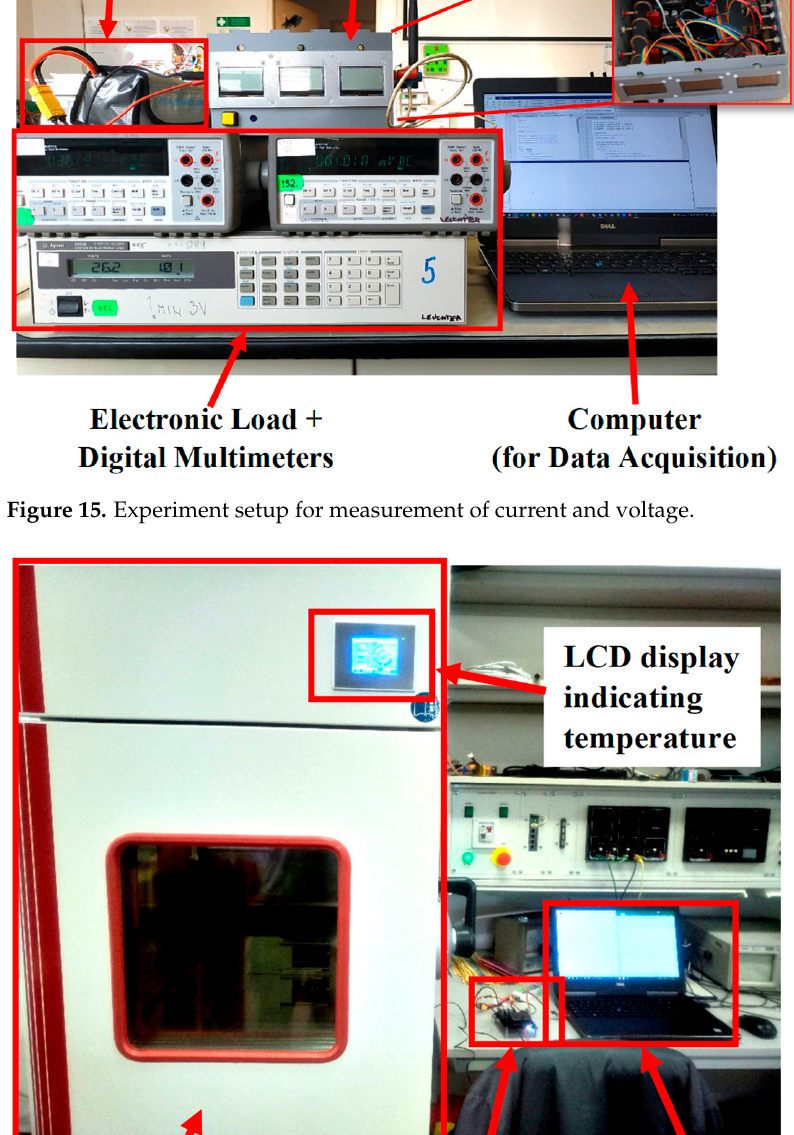
Figure 14. Dependence of balancing current on Cell voltage.